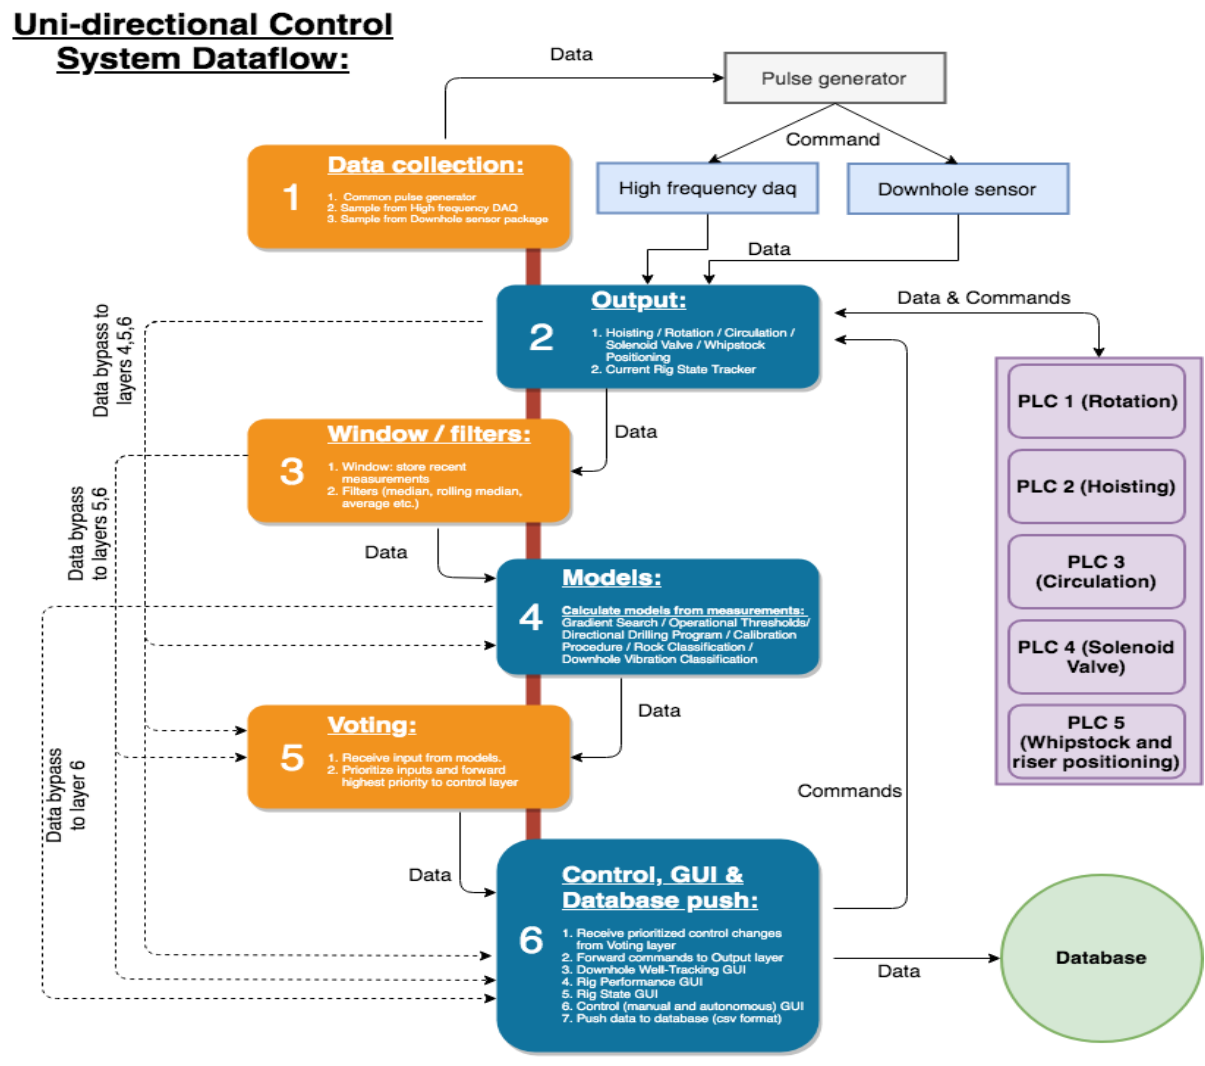
Figure A.1: Implemented control system illustrating layers and dataflow internally and externally with PLCs and sensor